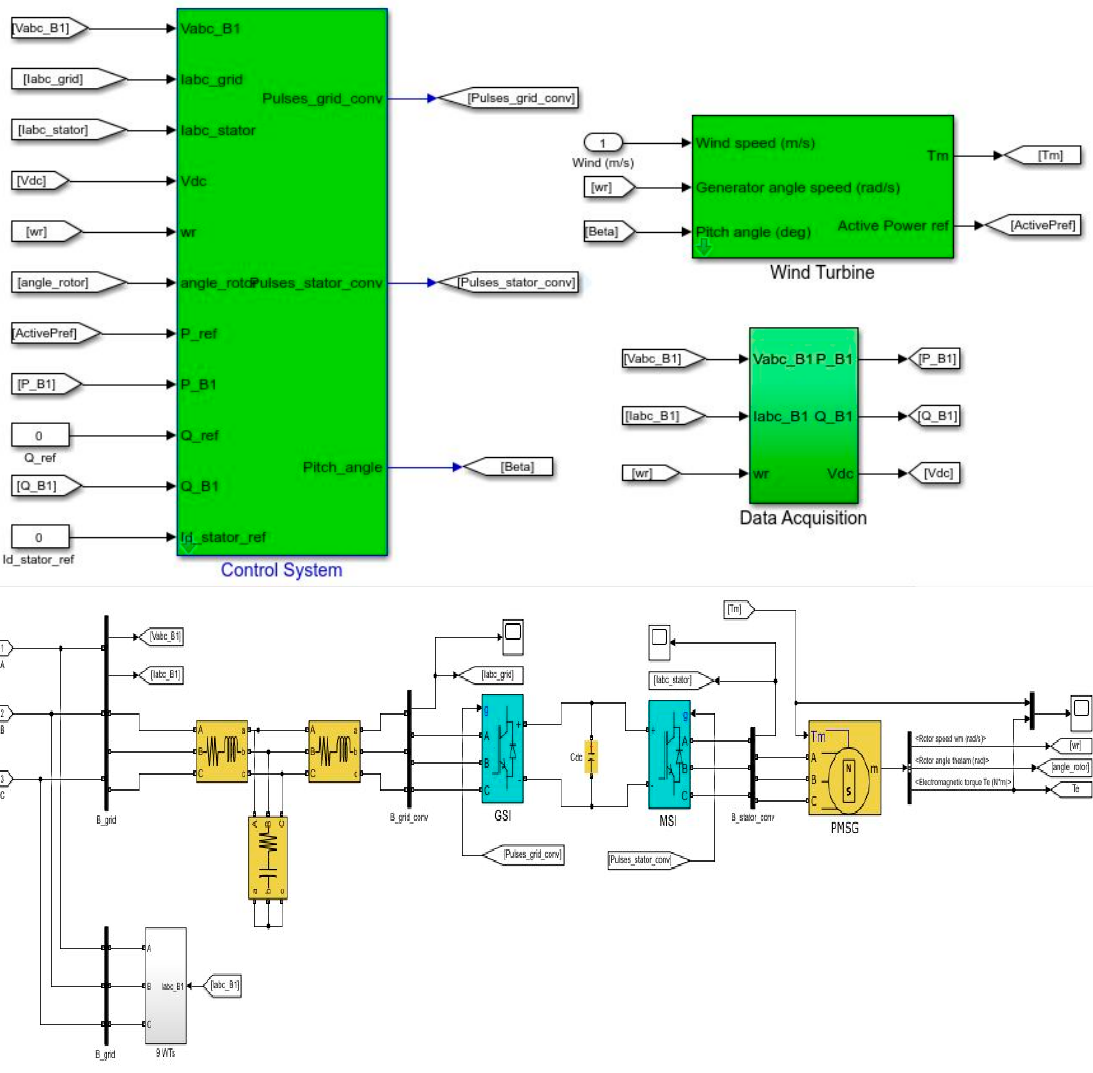
Figure 10. PMSG-based 20 MW wind farm SIMULINK model.